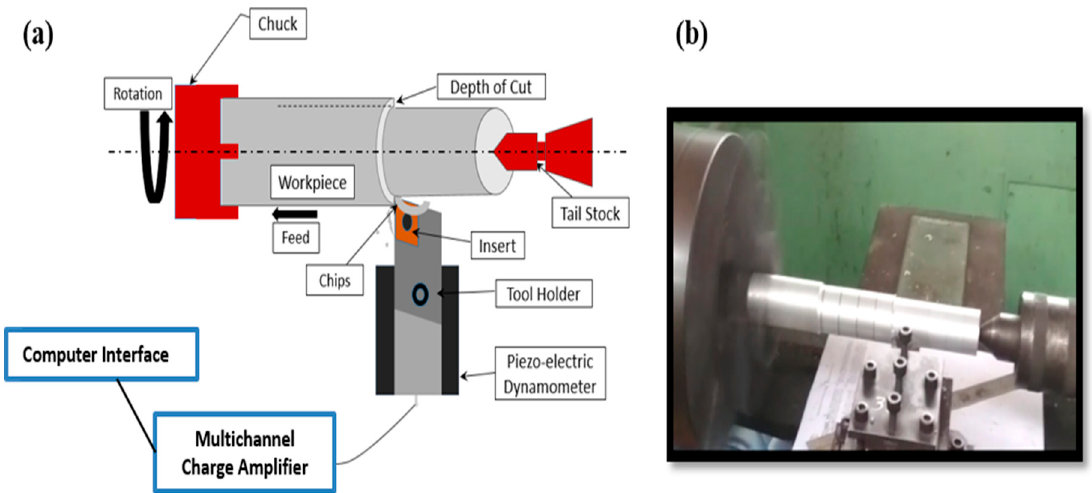
Figure 1. Machining specimens: ( a ) metal matrix composite (MMC), as casted; ( b ) MMC, after machining; ( c ) Base alloy, after machining.